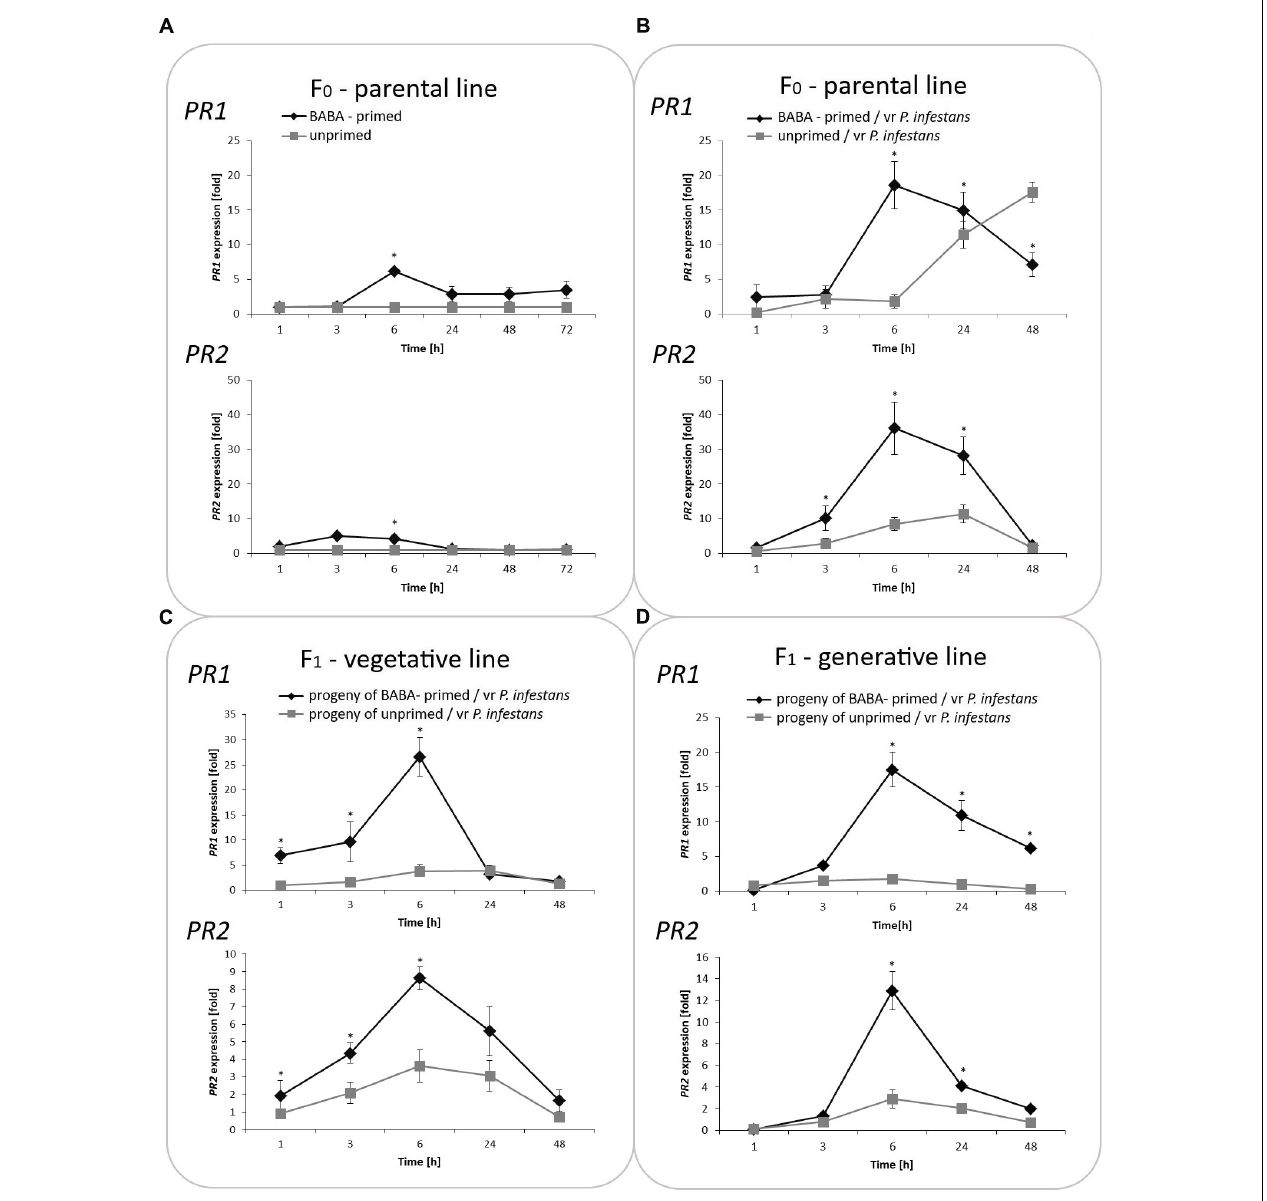
FIGURE 2 | Treatment with BABA reprograms SA-dependent gene transcription. The RT-qPCR analysis of PR1 and PR2 gene expression in BABA primed leaves of potato plants followed by challenge inoculation with P. infestans (at 72 h after BABA treatment) in parental line F 0 (A,B) . Analyses were performed at 0–48 h after 5 mM BABA exposure and 1–48 hpi after challenge inoculation. Transcriptional priming of PR1 and PR2 gene expression after P. infestans inoculation in the offspring of BABA-primed F 1 - vegetative line (C) , and F 1 - generative line (D) . Light columns refer to unprimed, while dark columns - to primed plant progeny. Values represent means of data ± SD of at least three independent experiments. Asterisks indicate values that differ significantly from unprimed (water treated) or unprimed and P. infestans inoculated potato leaves at P < 0.05 ( ∗ ),